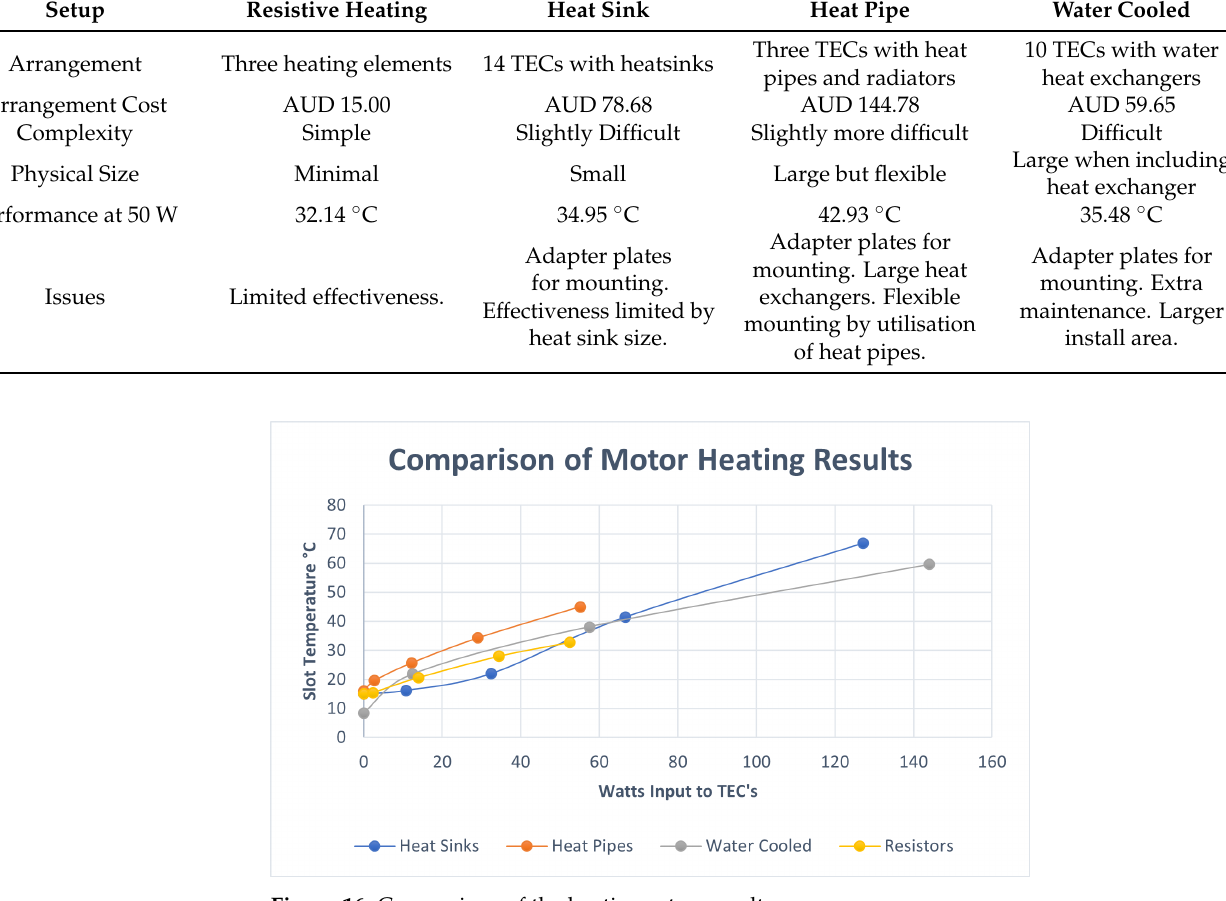
Figure 16. Comparison of the heating setup